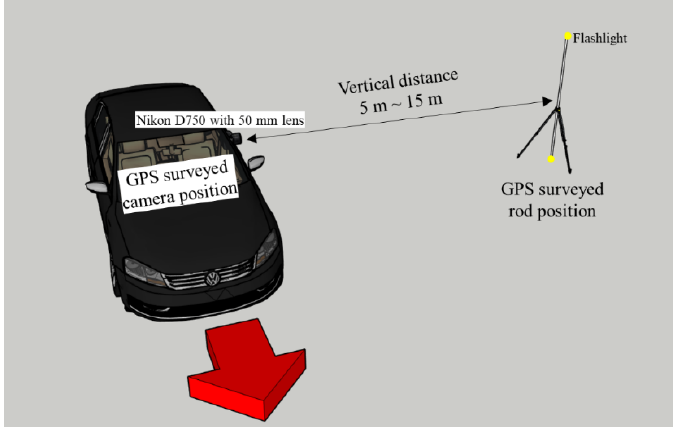
Figure 13. Illustration of the RSE experiment.